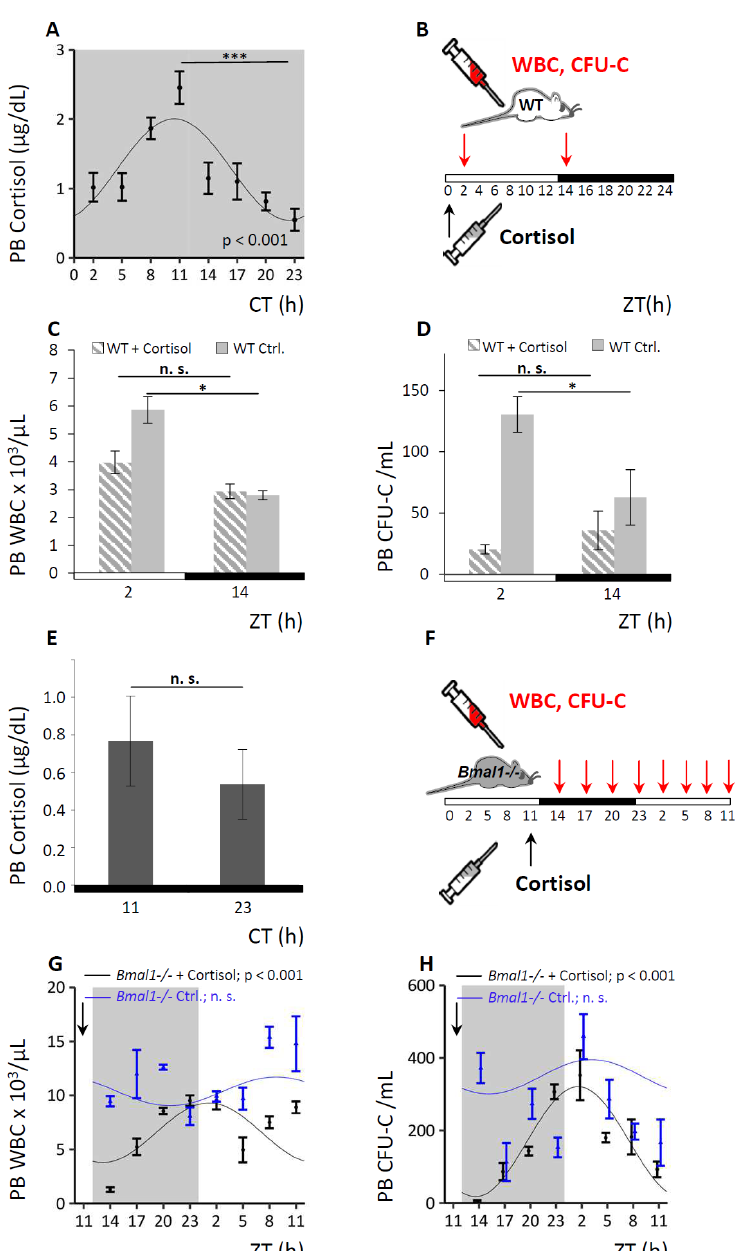
Figure 6. Circadian hematopoietic cell oscillation is modulated by cortisol. A. WT mice were held under DD conditions and endogenous PB cortisol levels were assessed over time via Cosinor analysis ( n = 8 mice per time point). B–D. WT mice were analyzed under LD conditions after cortisol application. A scheme of the experimental set-up is shown in ( B ): a single dose of cortisol (in carrier fluid) or carrier fluid only (control) was injected at ZT0 (black arrow) and PB was collected at ZT2 and ZT14 (red arrows). Enumeration of PB WBC ( C ) and CFU-C counts ( D ) was performed, hatched bars indicate cortisol-treated, grey bars control treated mice ( n = 10 mice per each group and time point). E. Bmal1 − / − mice were kept under DD conditions and endogenous PB cortisol levels were assessed at ZT11 and ZT23 ( n = 8 mice per time point). F–H. Bmal1 − / − mice were analyzed under LD conditions over a period of 24 h after cortisol application. Sinusoidal function was obtained by Cosinor analysis (see Table 1 for sinusoidal rhythm parameters). A schematic experimental set-up is shown in ( F ): mice received a bolus of cortisol (in carrier fluid) or carrier fluid only (control) at ZT11 (black arrow) and PB was collected over a period of 24 h (red arrows). Enumeration of PB WBC ( G ) and CFU-C counts ( H ) was performed, black lines indicate cortisol-treated ( n = 5–7 mice per time point), and blue lines diluent-treated Bmal1 − / − mice ( n = 5–15 mice per time point). Asterisks: * p < 0.05, *** p <